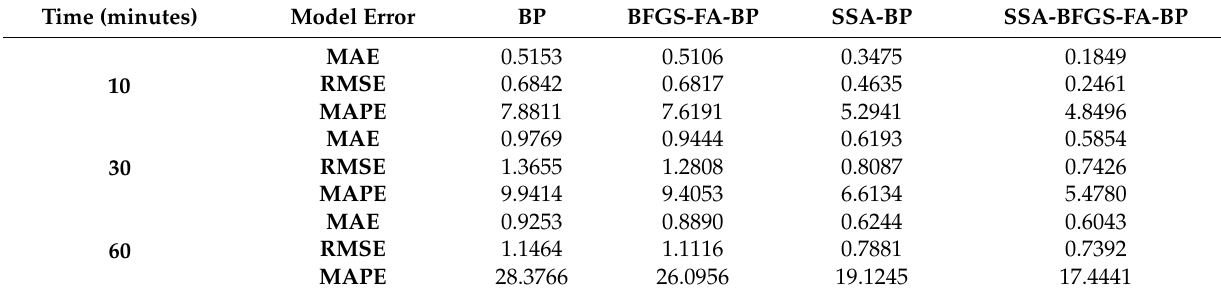
Table 11. MAE, RMSE, and MAPE of various intervals in one site for each forecasting